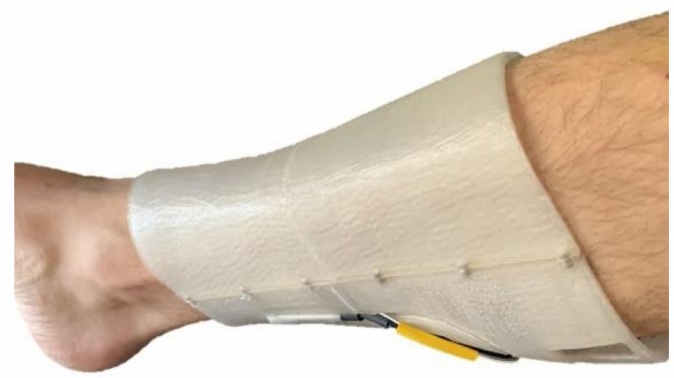
Figure 14. Real model over the